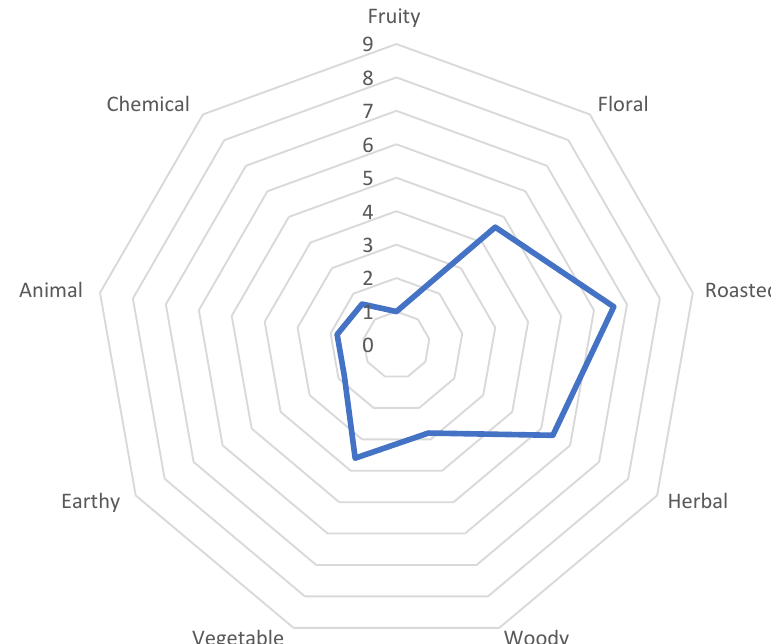
Figure 3. Sensory analysis (QDA) of hopped unfermented wort .